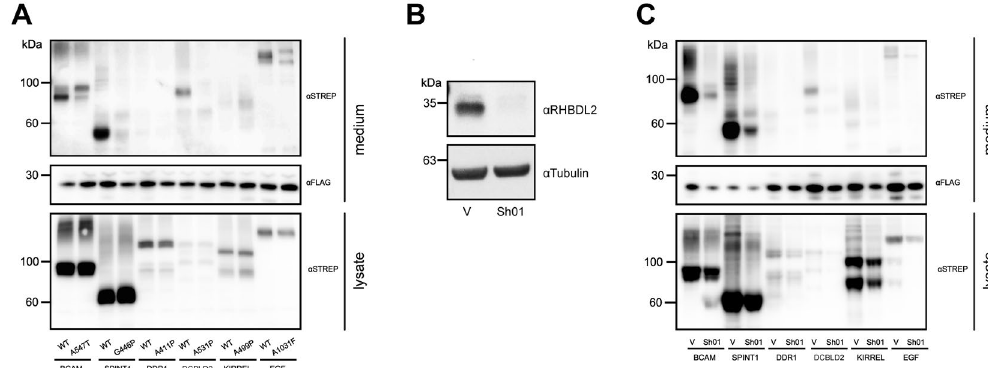
Figure 4. Endogenous RHBDL2 cleaves the newly identified substrates. ( A ) Strep tagged wild-type (WT) or P1-mutant substrates were expressed in HeLa cells, and shedding (in the presence of 10 µ M BB94) was analysed as previously described. ( B ) RNA interference using stable expression of shRNA “01” 8 specifically eliminates endogenous RHBDL2 protein in HeLa cells. Human RHBDL2 was visualised using a specific antibody (Protein Tech, 12467-1-AP at 1:500). V, pLKO.1 vector control; Sh01, specific shRNA targeted against the coding region of human RHBDL2 8 ; ( C ) Strep tagged substrates were transfected into HeLa cells stably transduced with either empty vector pLKO.1 (V) or shRNA directed against RHBDL2 (Sh01) 8 . The cleavage assay was performed as previously described 8